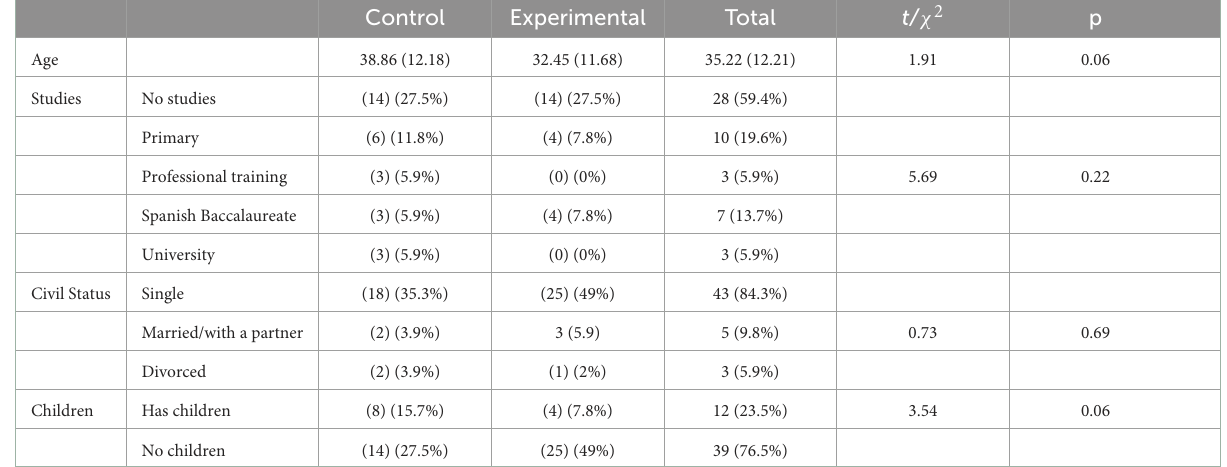
TABLE 1 Sociodemographic characteristics of the